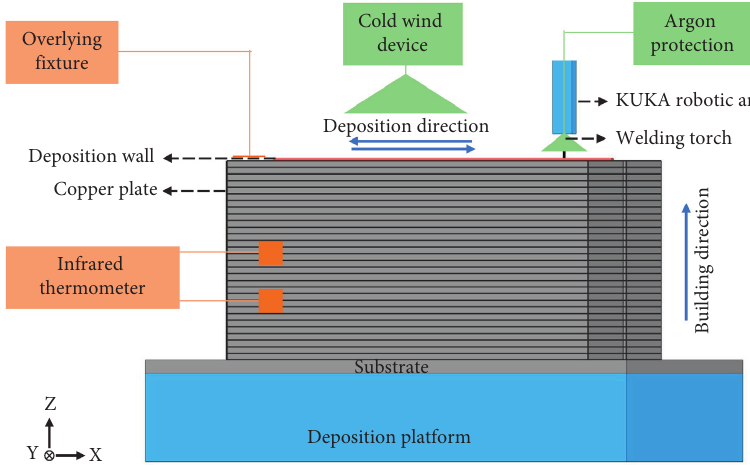
Figure 1: CMT arc additive die manufacturing device.